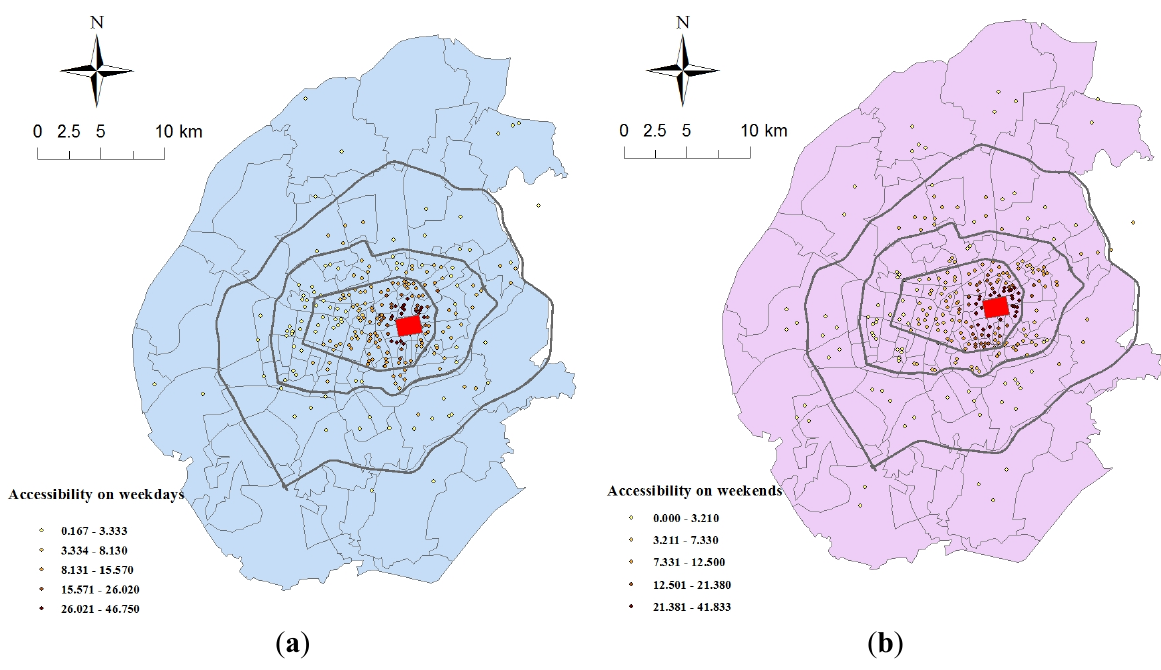
Figure 6. ( a ) Access to public transport to Zhongjie on weekdays; ( b ) Access to public transport to Zhongjie on